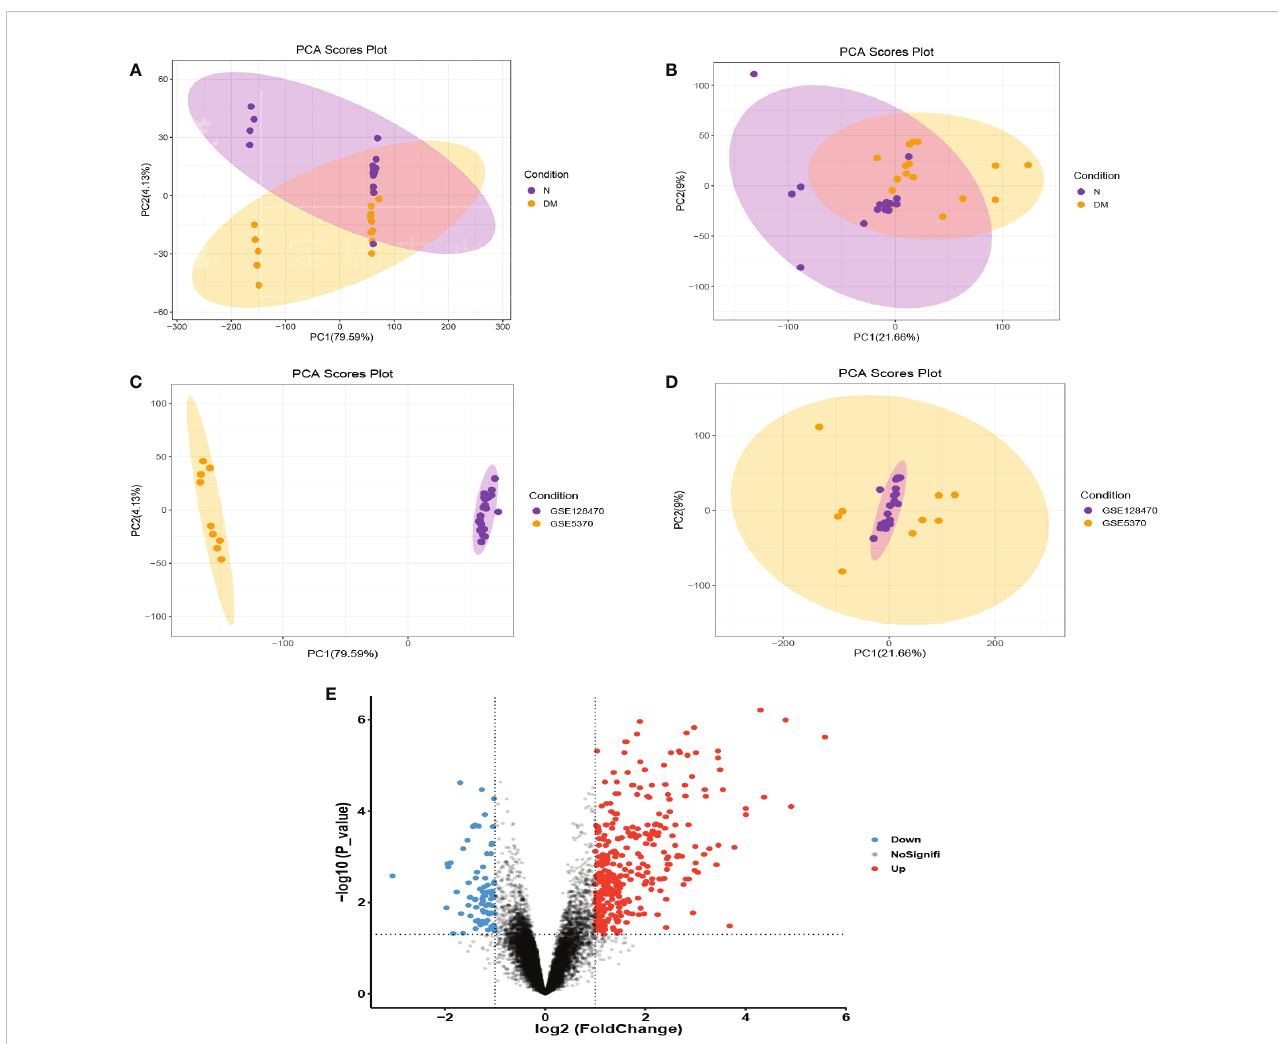
FIGURE 2 (A, B) Before and after normalization, two-dimensional PCA cluster diagrams of the GSE128470 and GSE5370 datasets. (C, D) Before and after normalization, two-dimensional PCA cluster diagrams of normal and DM samples. (E) In the combined dataset, a volcano map shows differentially expressed